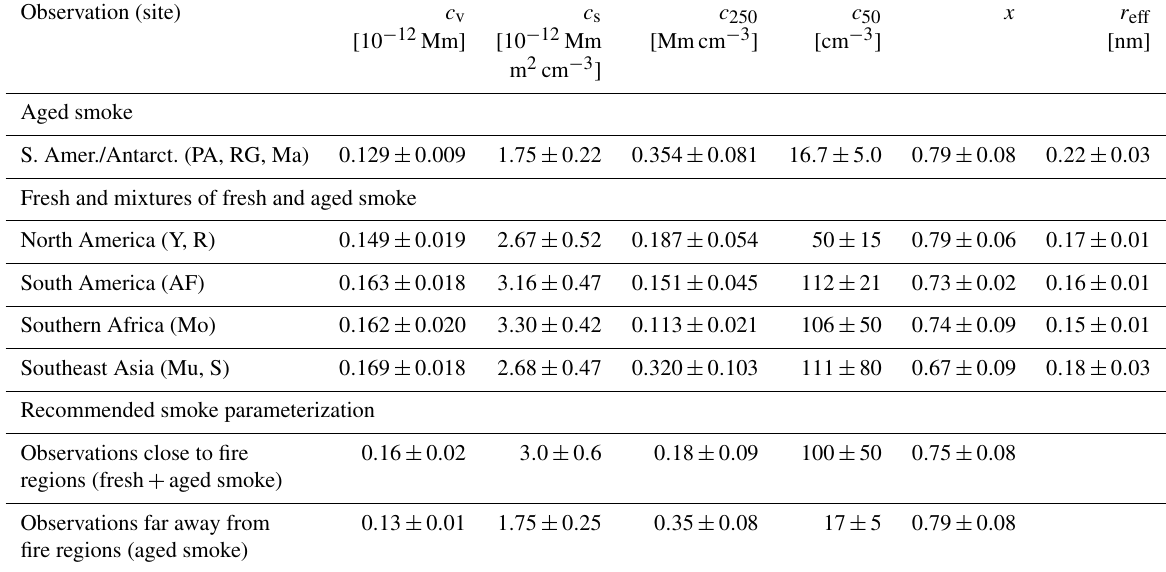
Table 3. Smoke conversion parameters required in the conversion of the particle extinction coefficient σ at 532nm into particle number concentrations n 50 and n 250 , surface area concentration s , and volume concentration v . The mean values and SD for c v , c s , c 250 , c 50 , and x are obtained from the extended AERONET data analysis. Effective radius r eff information is given as well. The conversion factors are derived from the AERONET observations at Yellowknife (Y), Reno (R), Alta Floresta (AF), Punta Arenas (PA), Rio Gallegos (RG), Marambio (Ma), Mongu (Mo), Mukdahan (Mu), and Singapore (S). The conversion parameters for South America (AF), southern Africa (Mo), and Southeast Asia (Mu, S) consider observations with AOT > 0.9 at 532nm only. c v c s c